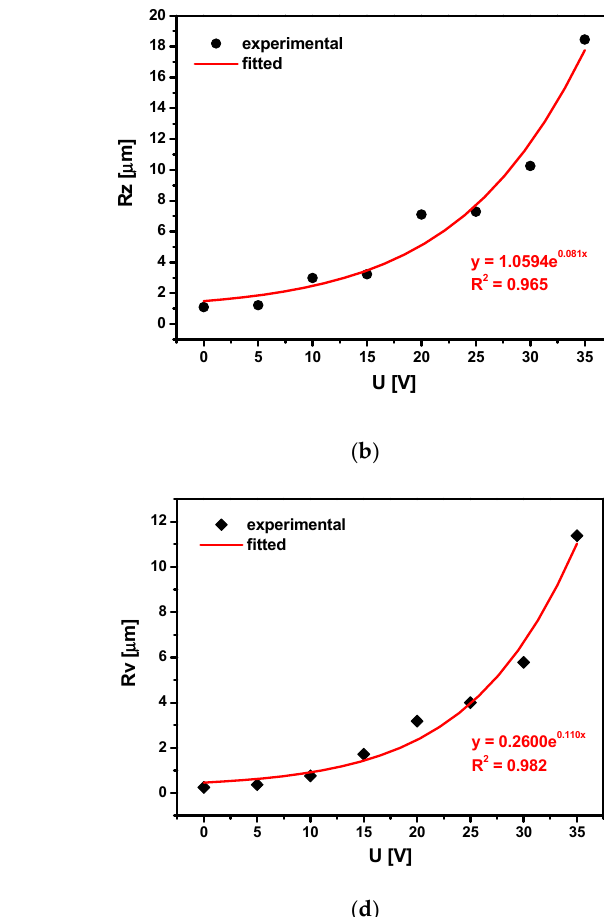
Figure 11. Roughness profile for the Ti-13Zr-13Nb alloy surface before and after anodizing at 15–35 V. Basic surface texture parameters for the Ti-13Zr-13Nb alloy surface as a function of anodizing voltage are presented in Figure 12.